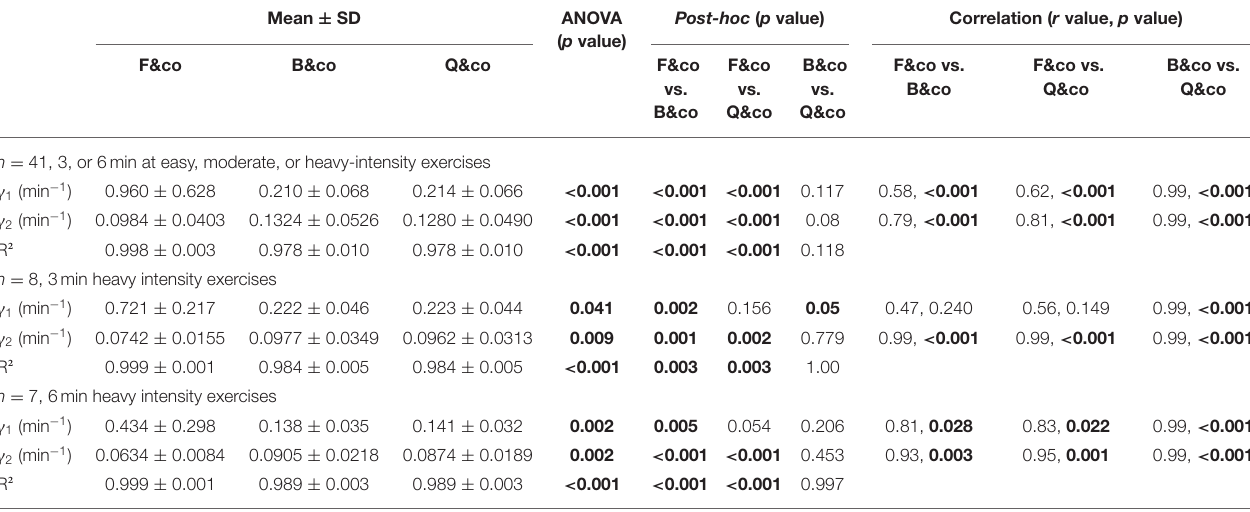
TABLE 3 | Mean values of the velocity constants γ 1 and γ 2 along with the R 2 values of the fits on the experimental data of Freund et al. (1989).